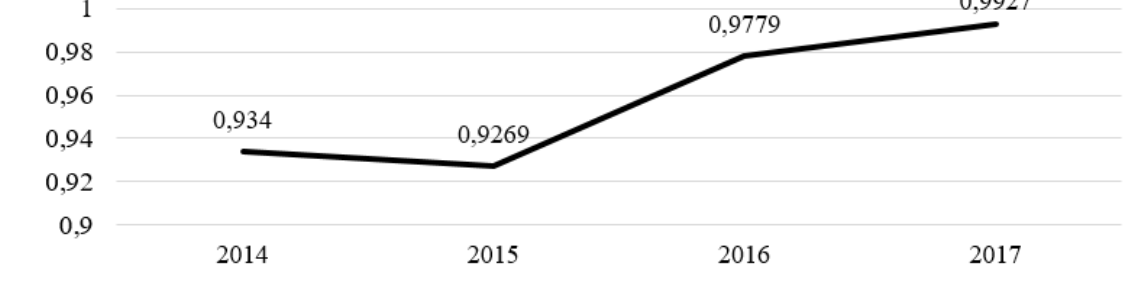
Figure 2. Integral indicator of financial decentralization in